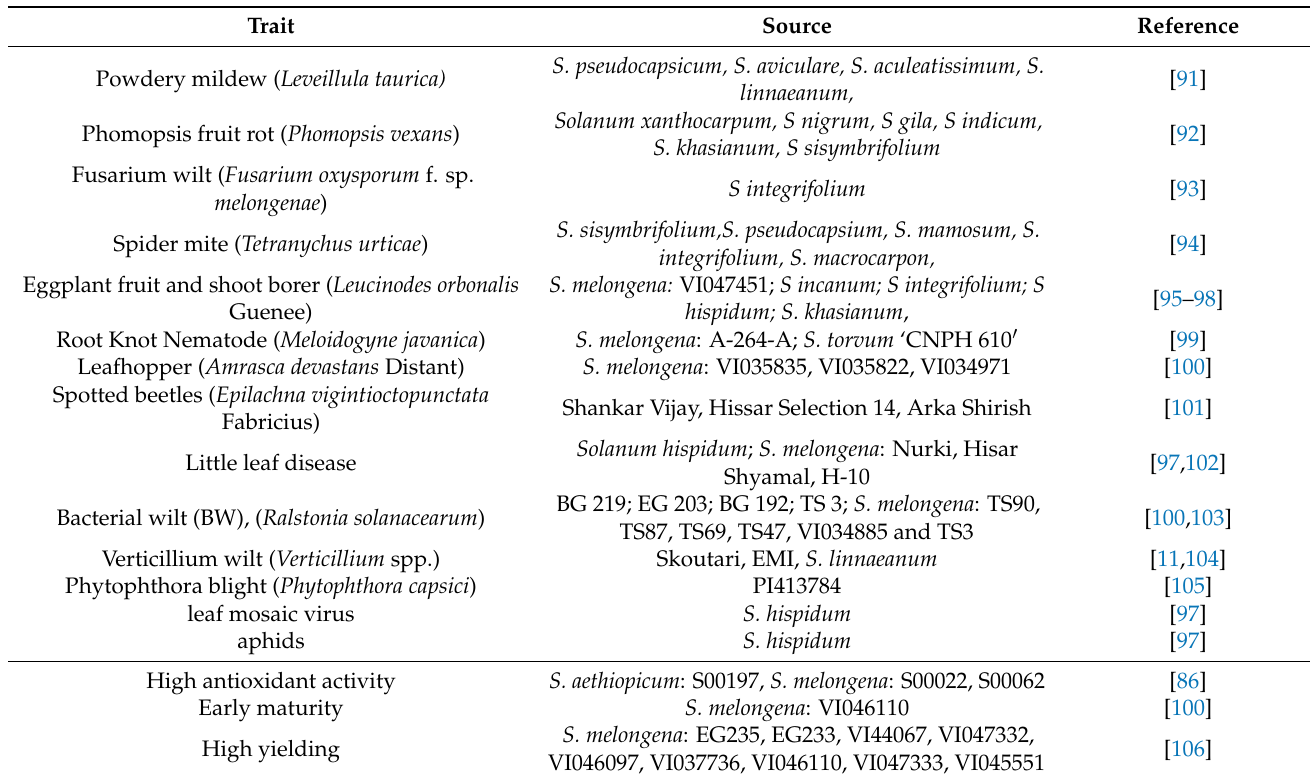
Table 6. Identified eggplant germplasms resistant to biotic stresses and useful traits for